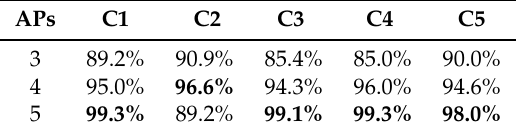
Table 5. Accuracies obtained using different numbers of APs in the third